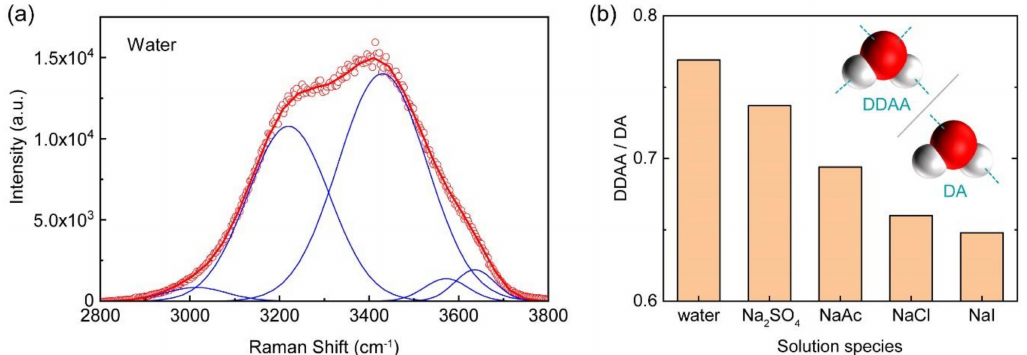
Figure 5. ( a ) Raman spectrum showing the OH stretching vibration of ultrapure water (red), which is fitted with five Gaussian sub-bands (blue). ( b ) Anion e ff ect on water structure of the sodium solutions. The y-axis is the ratio of the intensity of the peak at 3226 cm − 1 (highest intensity) to that of the peak at 3432 cm − 1 . The concentration of the 1:1 electrolyte was 1 M, and that of the 2:1 electrolyte was 0.33